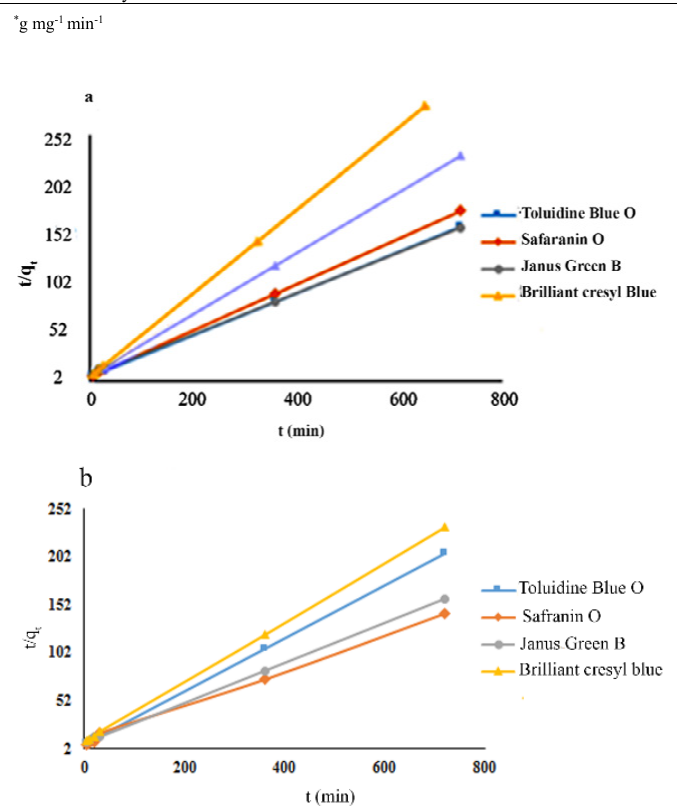
Fig. 2 . Plots of pseudo-second order kinetics of dyes adsorption over (a) TMU-16-